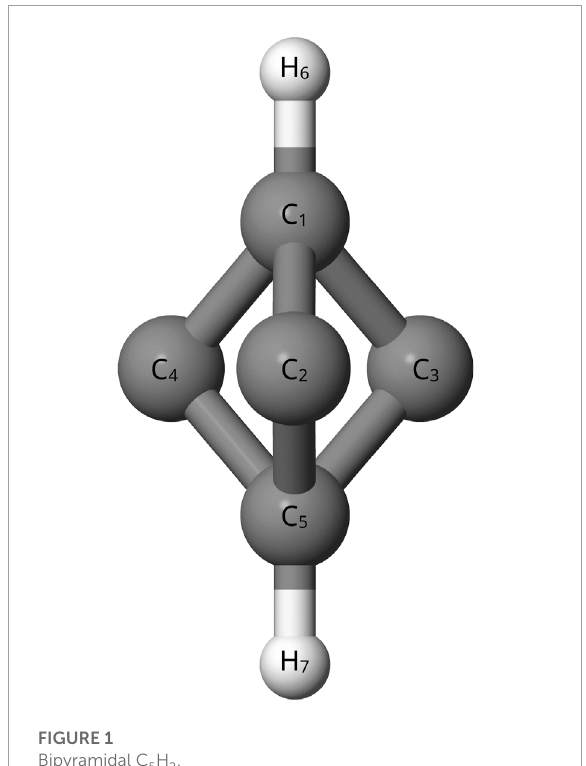
FIGURE 1 Bipyramidal C 5 H 2